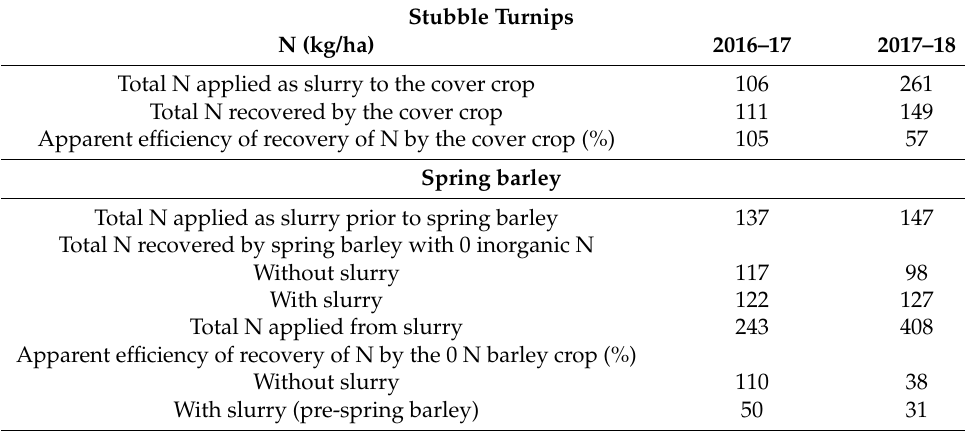
Table 13. Apparent N recovery efficiency in the stubble turnips and in the spring barley. Stubble Turnips N